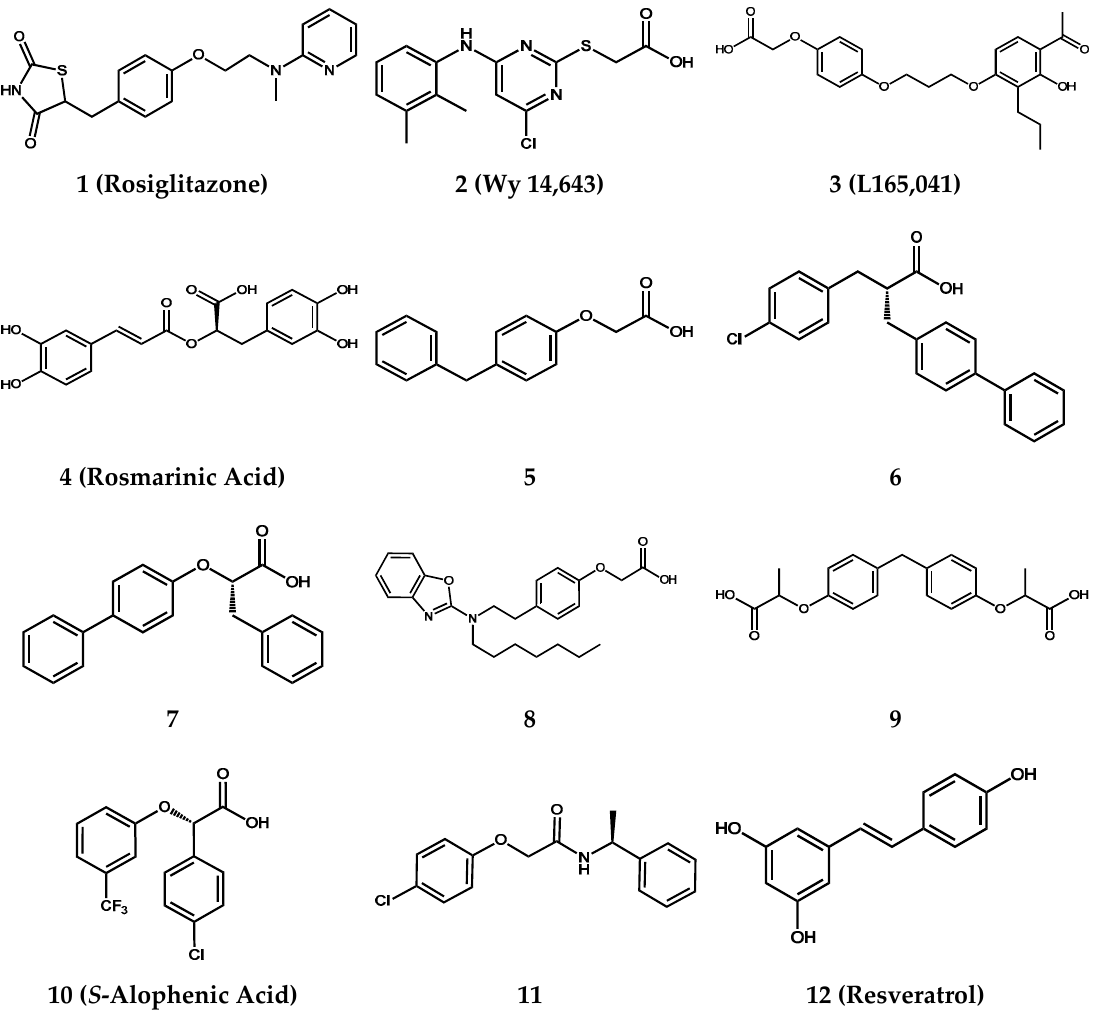
Figure 1. Molecular structures of the first 12 compounds involved in the screening.